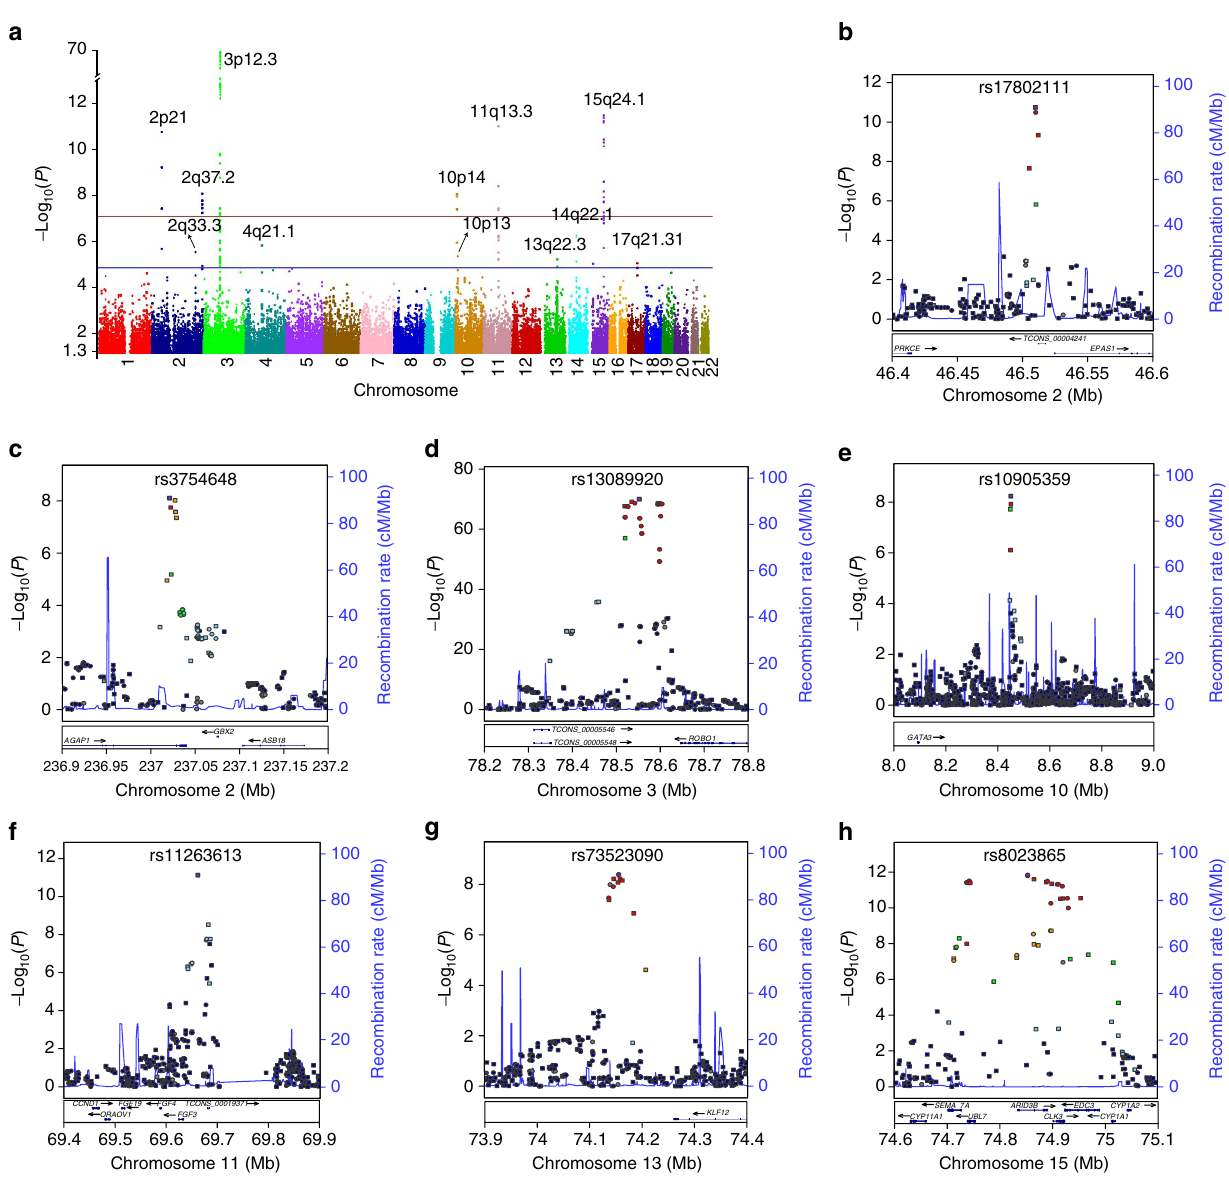
Figure 1 | Manhattan plots of the P values calculated from the genome-wide association study at the discovery stage. ( a ) Data were collected from 939 cases with craniofacial microsomia and 2,012 controls on 792,342 SNPs that had passed the quality control. The (cid:3) log 10 (logistic regression P value) of each SNP is shown as a function of genomic position on the autosomes (hg19). Genome-wide significance (solid red line; P r 6.3 (cid:2) 10 (cid:3) 8 ) and suggestive significance (solid blue line; P r 1 (cid:2) 10 (cid:3) 5 ) are denoted. ( b – h ) Regional plots shows the association of craniofacial microsomia risk with all significant loci, continuous genomic regions surrounding the lead SNPs, including 2p21 ( b ), 2q37.2 ( c ), 3p12.3 ( d ), 10p14 ( e ), 11q13.3 ( f ), 13q22.1 ( g ) and 15q24.1 ( h ). Each point represents a SNP plotted with its (cid:3) log 10 P value as a function of genomic position (hg19). Imputation analysis is shown with circles and direct genotyping with squares. In each regional plot, the purple symbol denotes the lead SNP, showing its name on the top of each plot. The colour coding of the rest of the SNPs showed in LD with the lead SNP: red, r 2 Z 0.8; gold, 0.6 r r 2 o 0.8; green, 0.4 r r 2 o 0.6; cyan, 0.2 r r 2 o 0.4; blue, r 2 o 0.2; grey, r 2 unknown. Recombination rates were estimated from ASN population of 1KG project (Mar 2012). Gene annotations were taken from the UCSC genome browser.